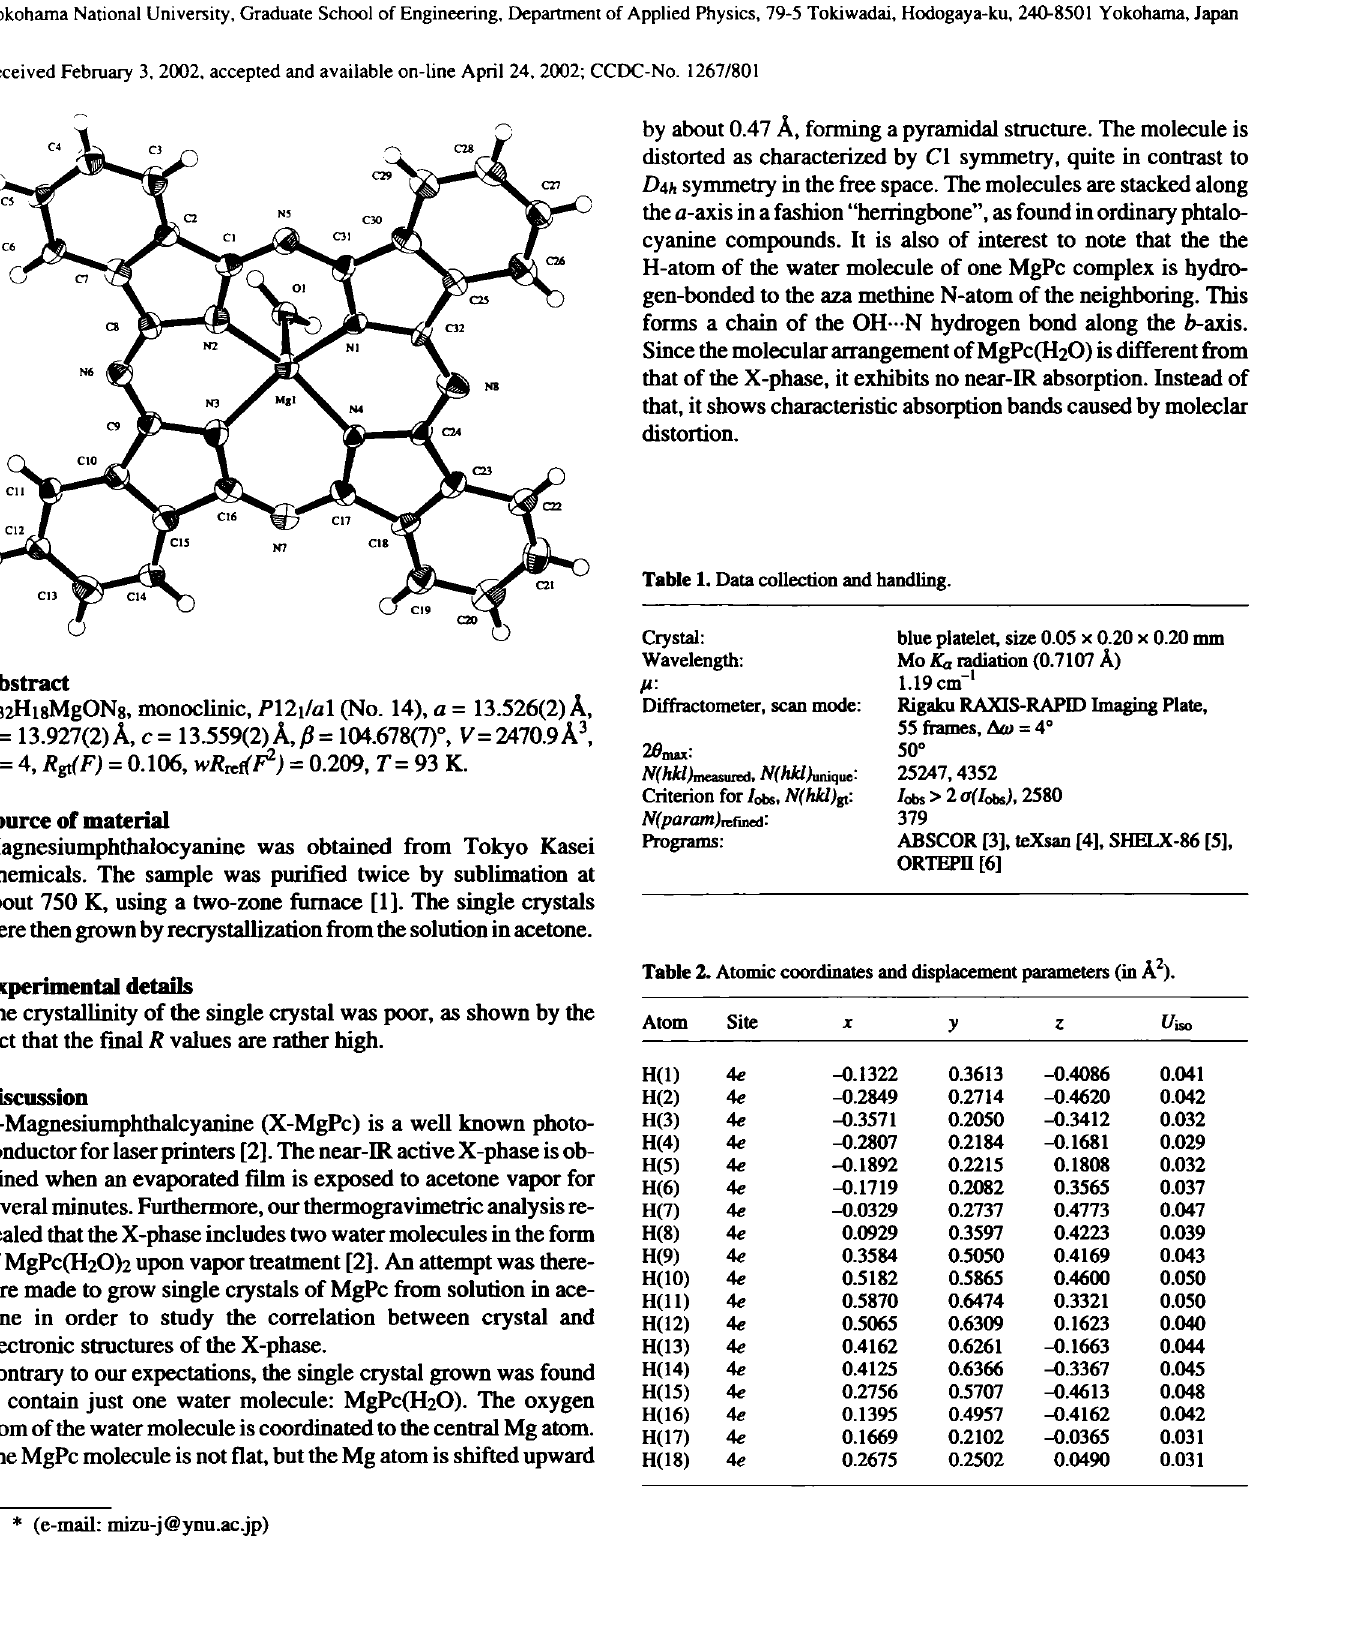
Table 2. Atomic coordinates and displacement parameters (in Â 2